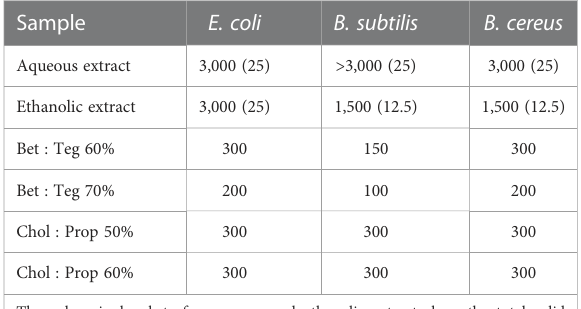
TABLE 2 Minimum inhibitory concentration in mg/L of total phenolics.